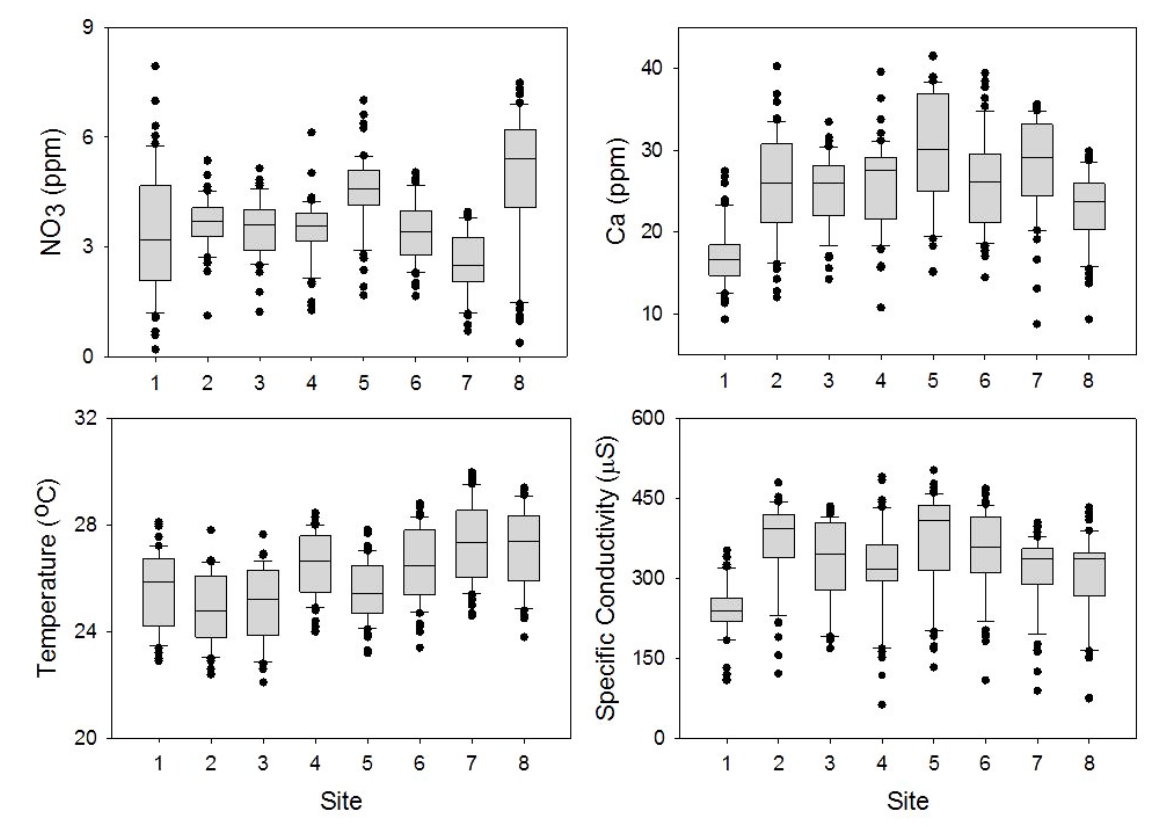
Fig. 2 . Box and whisker plots of the variability in representative stream physicochemical parameters in the Río Piedras Watershed.